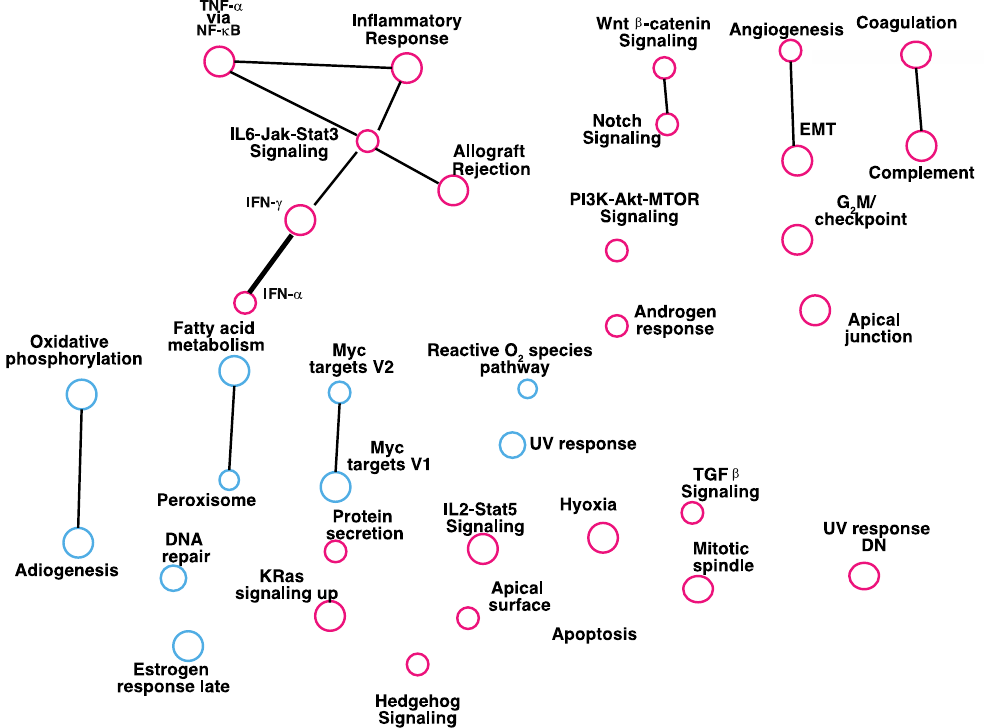
Figure 4. Expression of immune response gene sets correlates with RKIP expression in clinical breast cancers. Cytoscape Enrichment Map with each node (circle) represents a gene set with the indicated biological state. The expression levels of each gene set were either upregulated (red) or downregulated (blue) in low ‐ RKIP ‐ expressing cancers. Gene sets with shared genes are linked by edges ( dark lines) with thicknesses that correspond to the number of genes in common between two sets. Only gene sets with FDR < 0.1 and p < 0.03 are shown.